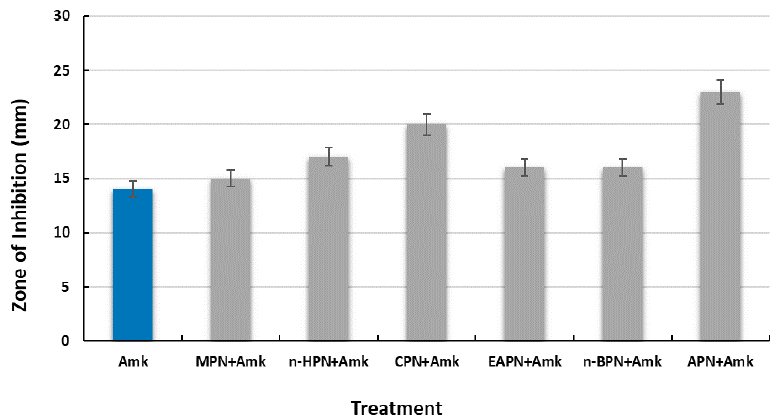
Figure 7. Antibiotic reversal activity of P. nigrum extracts in combination with amikacin (30 μg) for S. aureus .